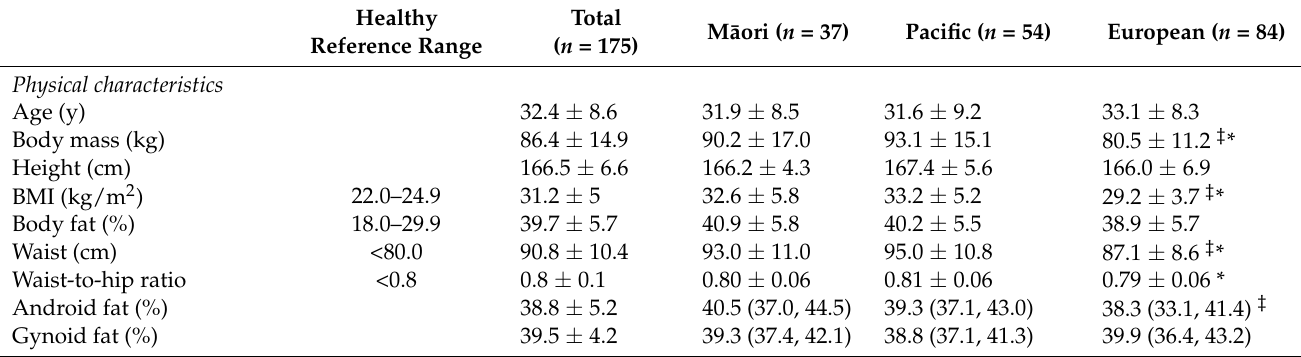
Table 1. Participant physical and metabolic health